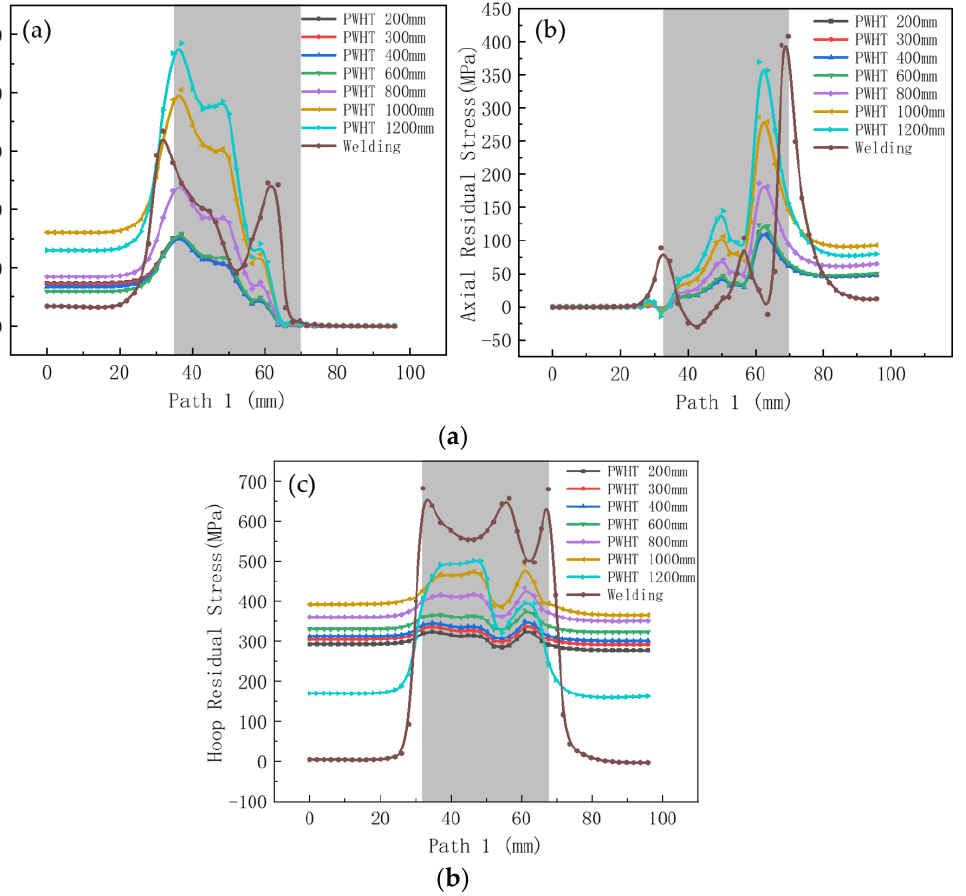
Figure 14. Effect of PWHT width on the residual stress distribution of Path 1: ( a ) radial, ( b ) axial, ( c ) hoop residual stress.